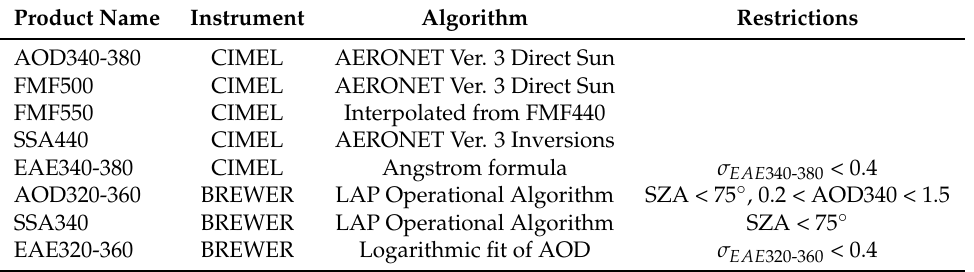
Table 1. The most important aerosol optical products are gathered here. The instrument that performed the measurement, the calculation algorithm, and any restrictions applied are included